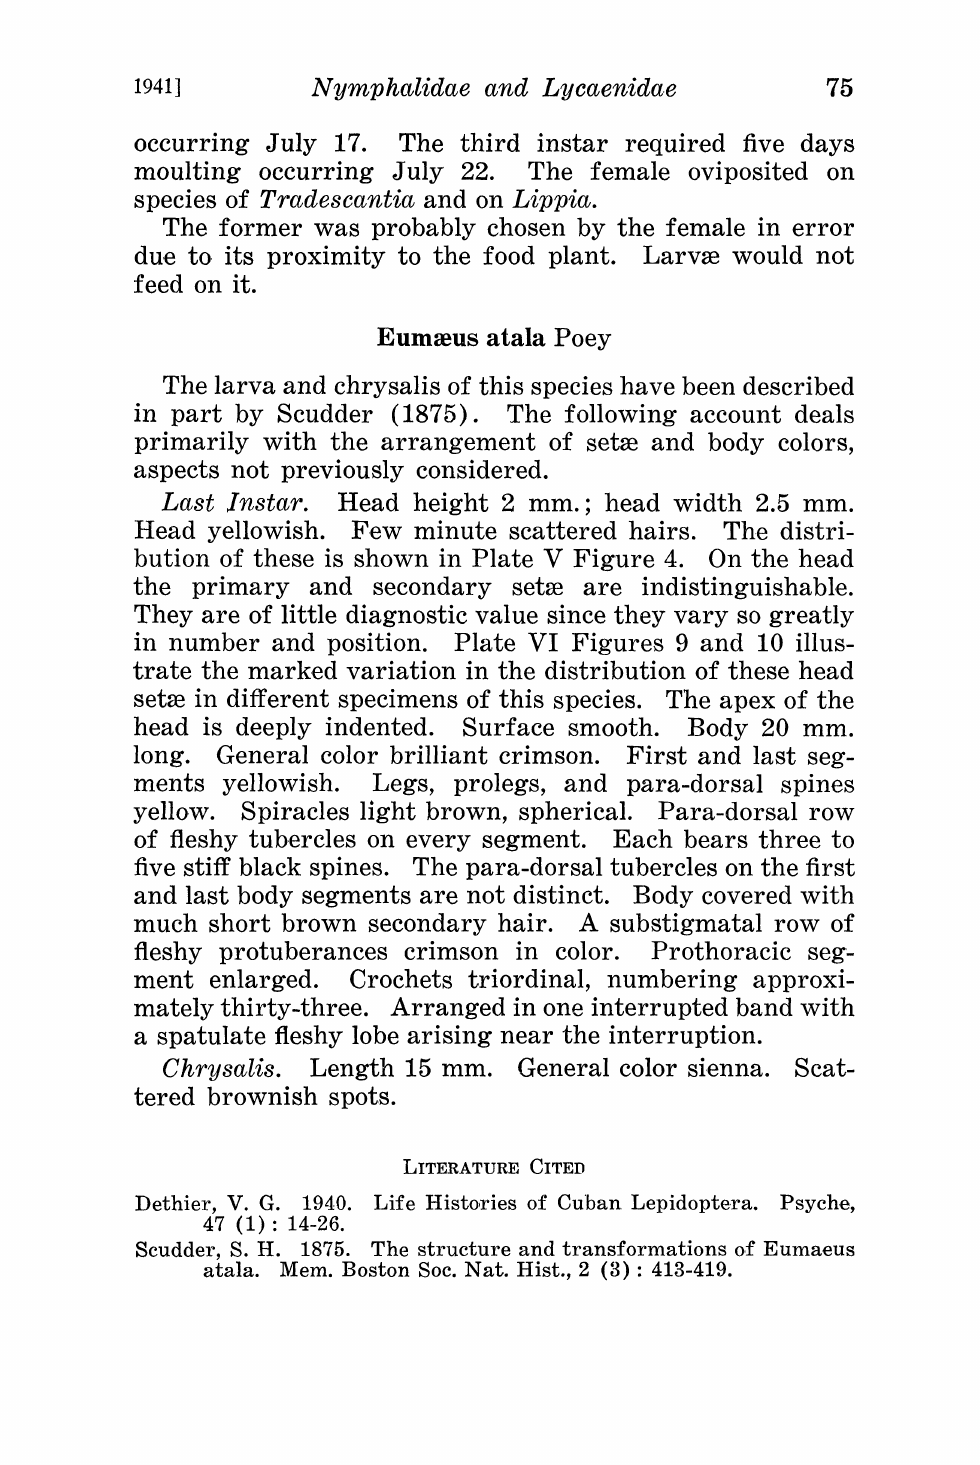
yellow. Spiracles light brown, spherical. of fleshy tubercles on every segment. Each bears three to five stiff black spines. The para-dorsal tubercles on the first and last body segments are not distinct. Body covered with much short brown secondary hair. fleshy protuberances crimson in